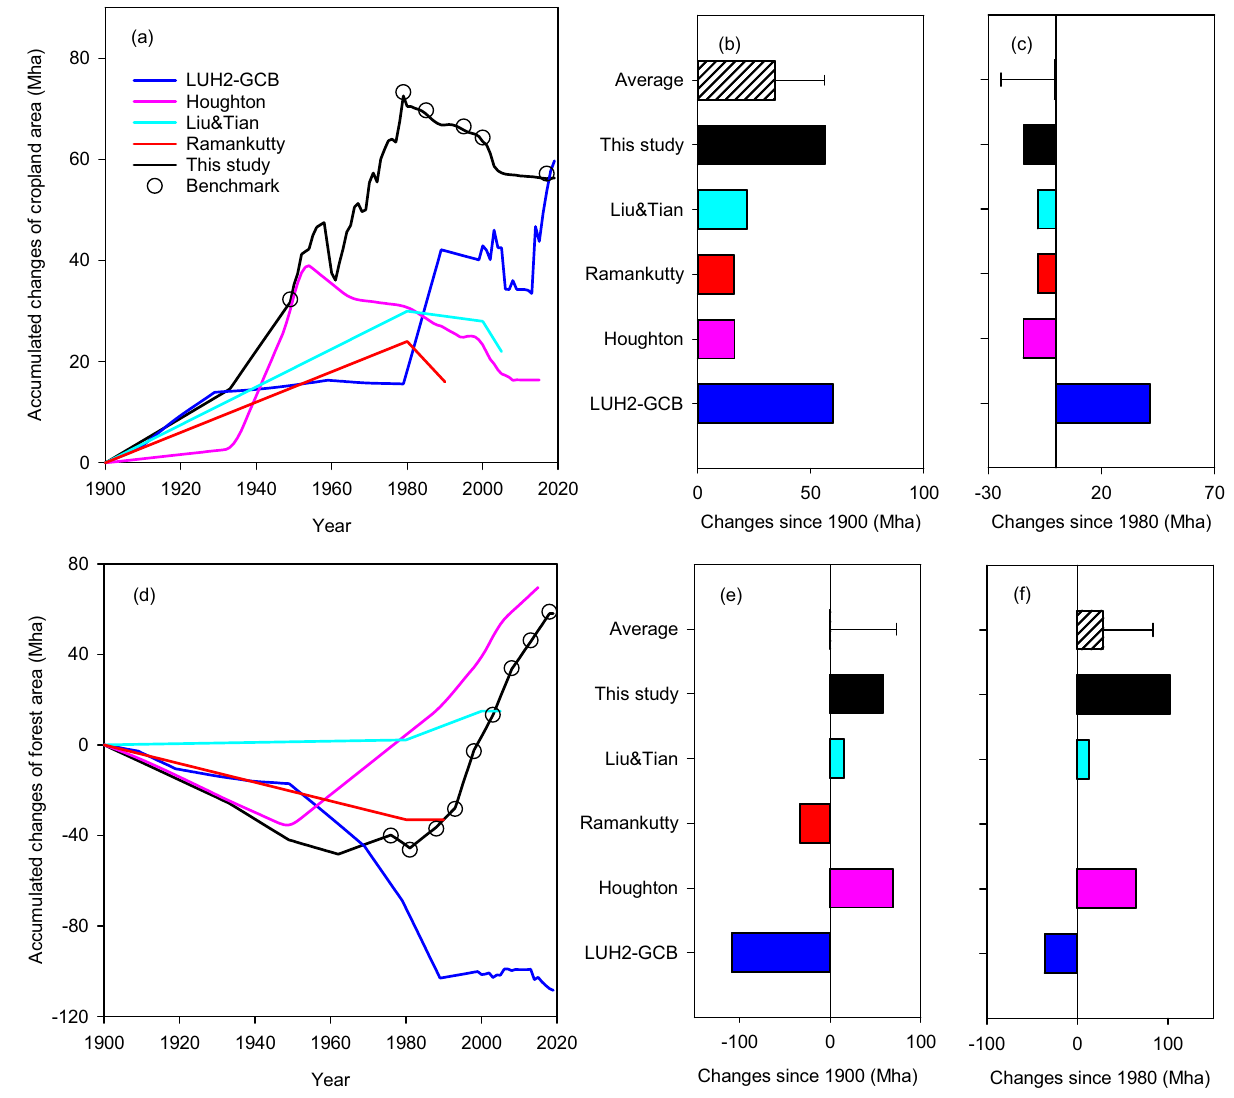
Fig. 1 | Temporal, net changes of cropland and forest from 1900 (unit: Mha). Panel a – c :cropland;panel d – f :forest;thebarchartsindicatethetotalaccumulated areas ( b , e ) from 1900 and ( c , f ) from 1980 until the last available year; LUH2-GCB was the latest version of LUH2 data used in Global Carbon Budget assessments projects (LUH2 used in MsTMIP and TRENDY were showed in Supplementary Figs. S7 and S10); Houghton data were derived from Houghton and Nassikas 20 and